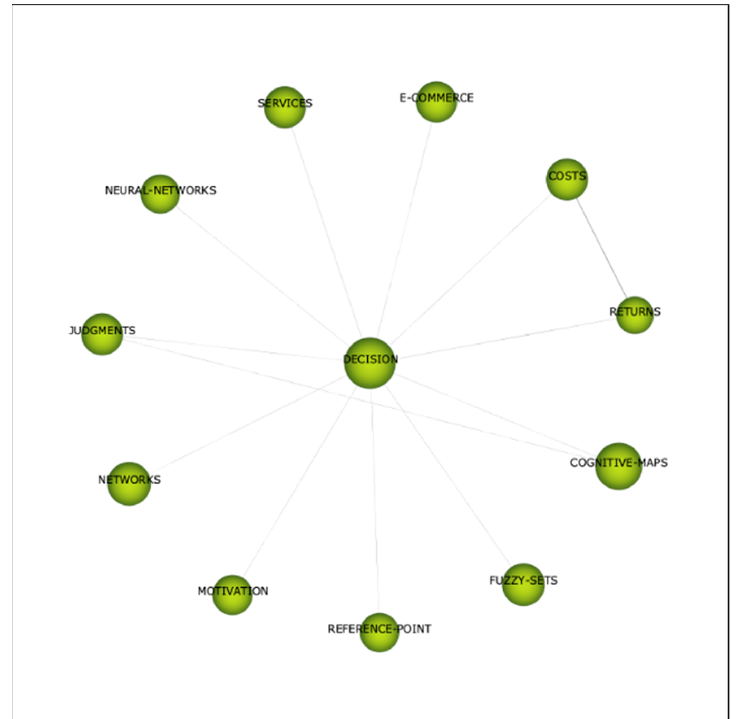
Figure A7. Decision cluster network.